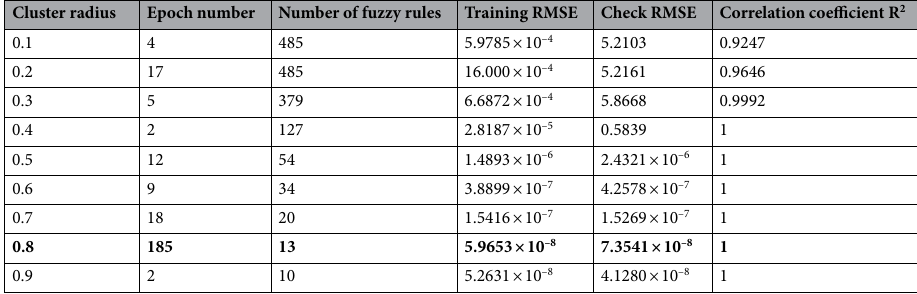
Table 3. Index sum’s comparative test results of cluster radius value from 0.1 to 0.9 with selected best fitted model. Bold values are illustrated later within the following section.